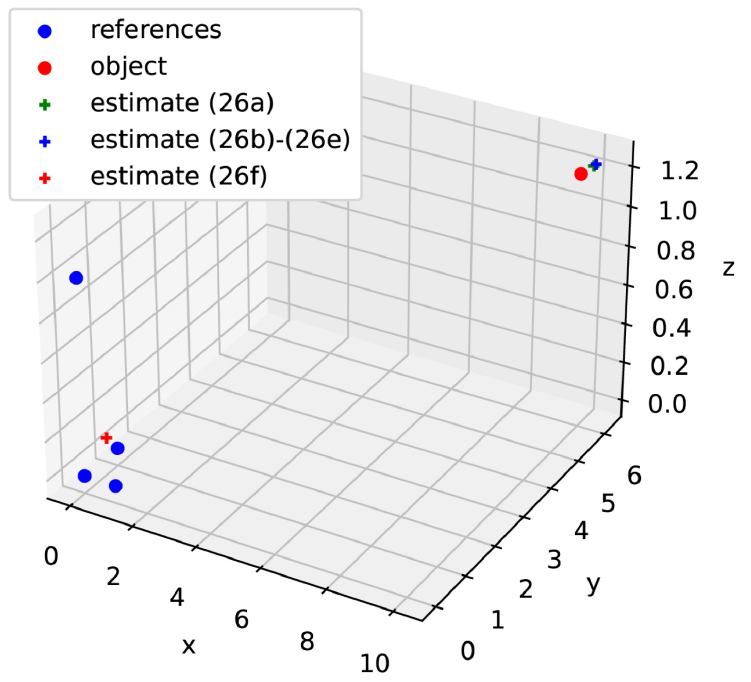
Fig 1. Geometric setup for positioning a 3D object with four